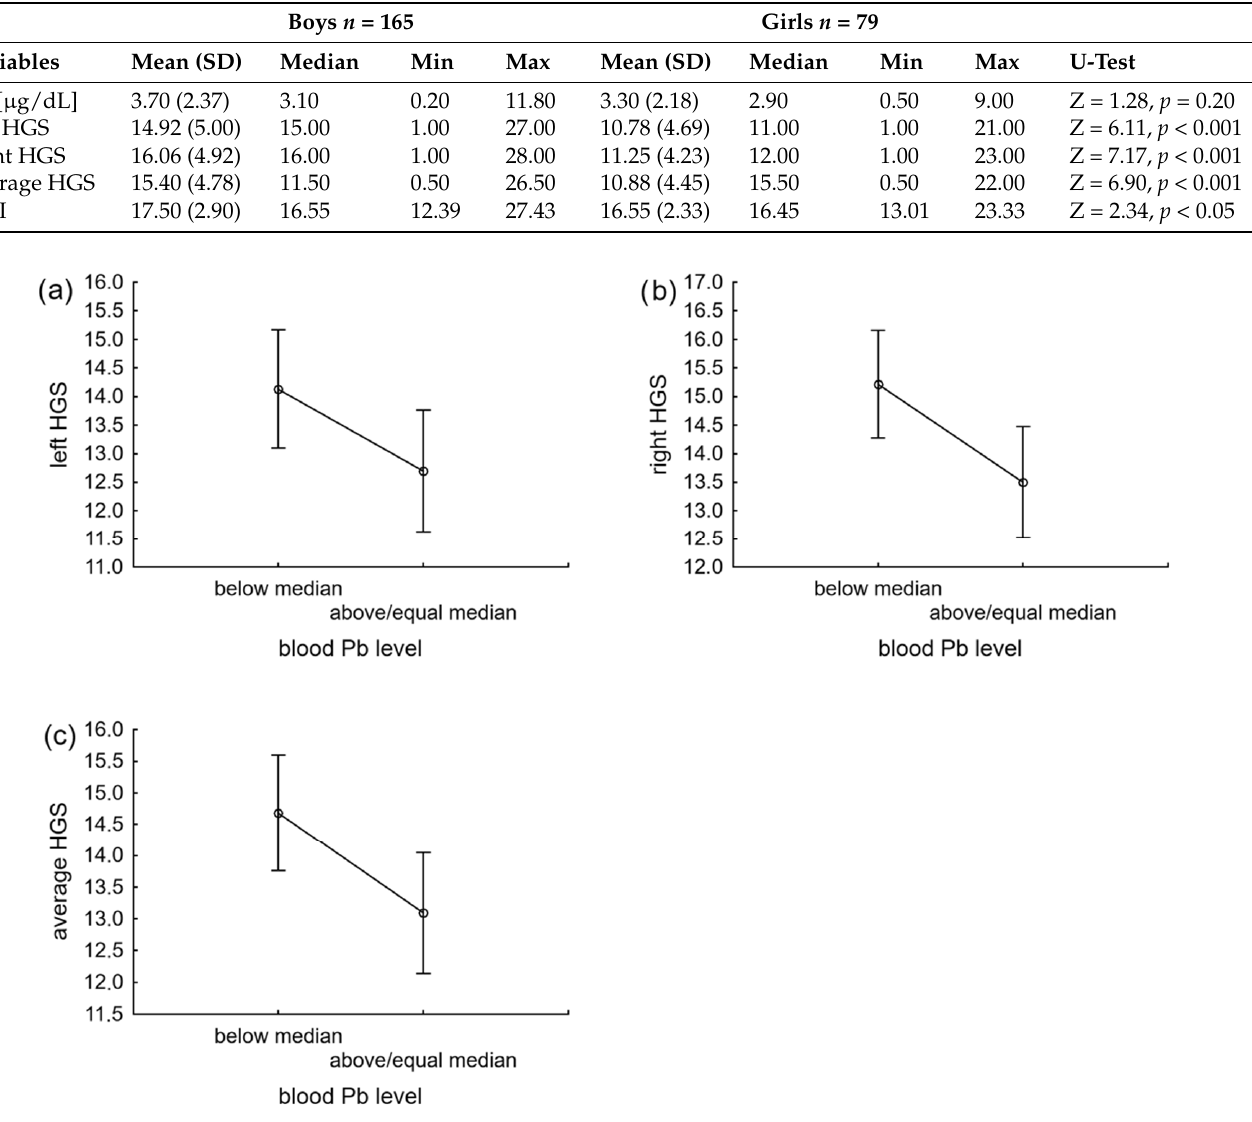
Table 1. Descriptive statistics and results of the Mann–Whitney U-tests for blood lead level and the three indicators of grip strength (left, right, average HGS) in preadolescent boys (9–11 years) and girls (9–10 years) from Polkowice 1996. Correlation between left and right HGS: r s = 0.80, p < 0.0001. Boys n = 165 Girls n = 79